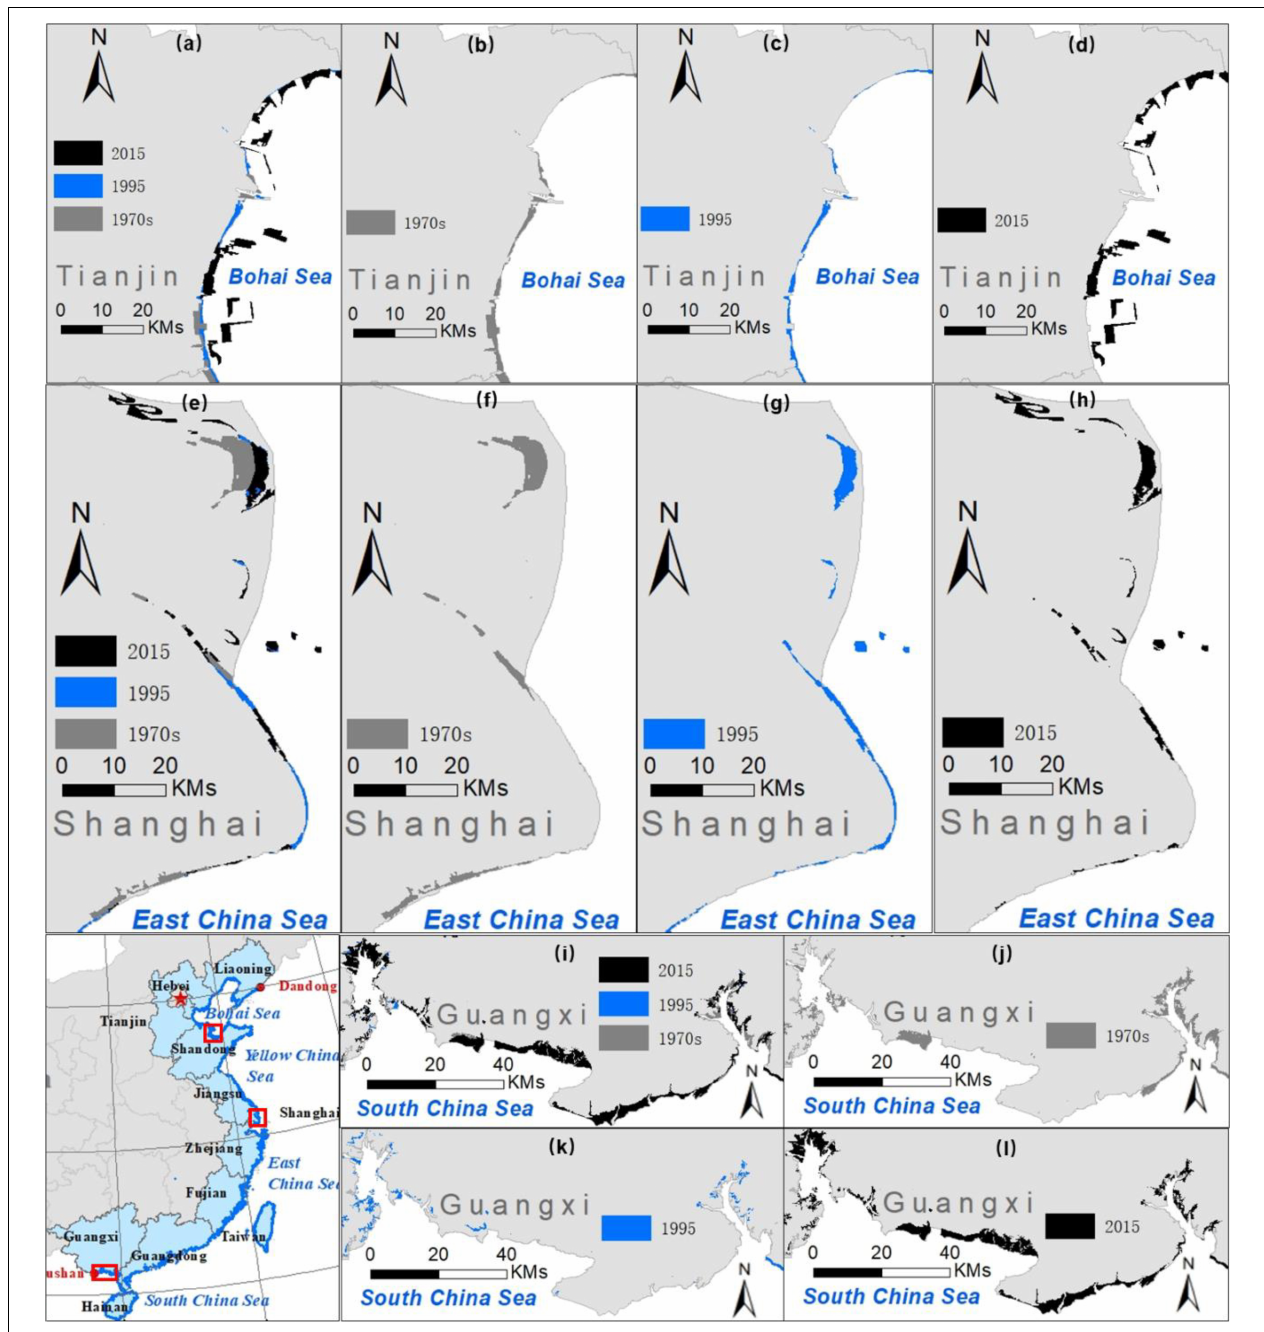
FIGURE 8 | Increase in human-constructed intertidal wetland at the Bohai Rim (A–D) , coastal Shanghai region (E–H) , and coastal Guangxi region (I–L) .